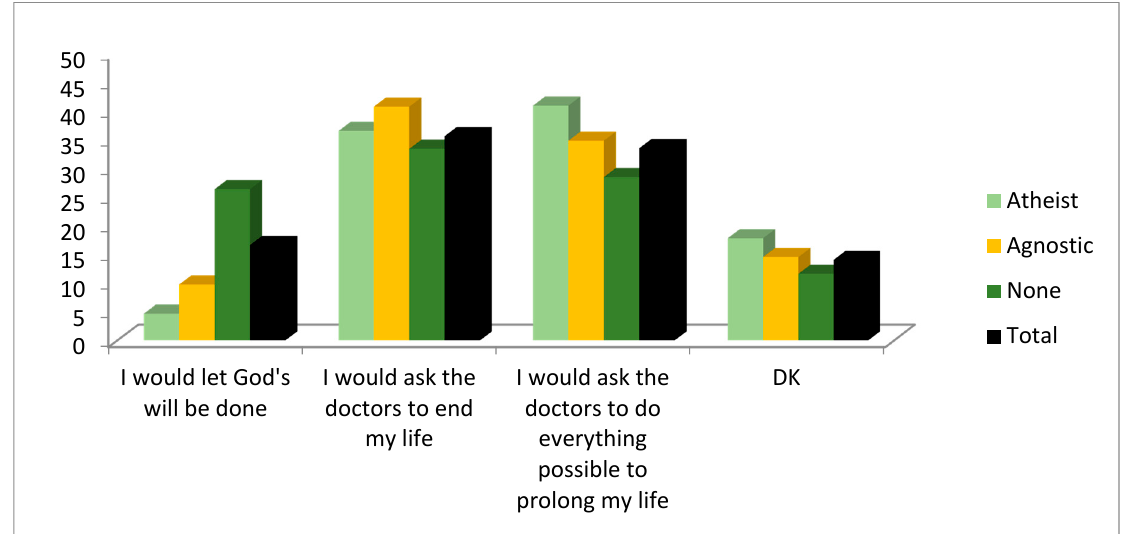
Figure 7. Personal decision regarding the end of life (in %). Based on 382 cases. Source: Author’s elaboration based on the Second National Survey on Religious Beliefs and Attitudes. Society, Culture and Religion Program, CEIL-CONICET, 2019.